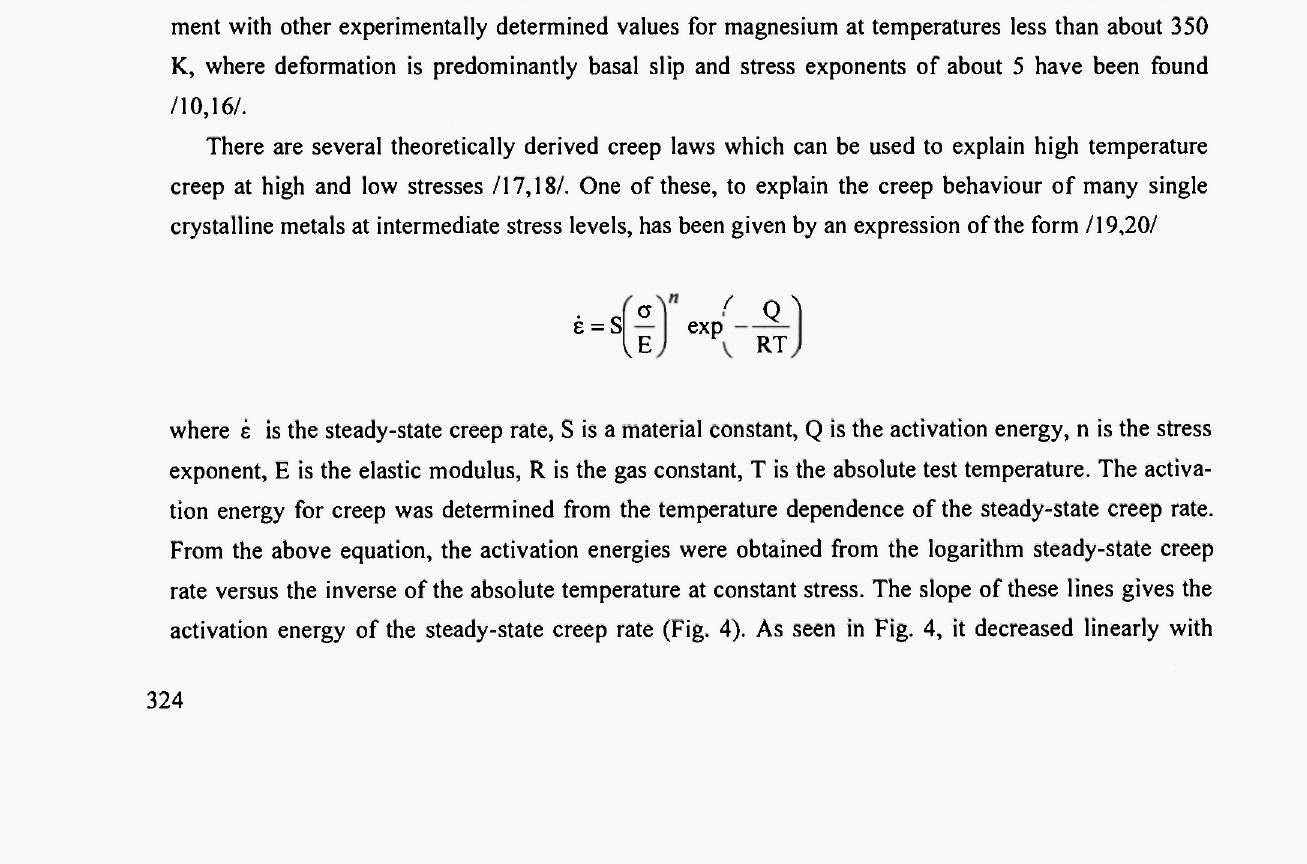
Fig. 2: The creep rate versus strain for Cd single